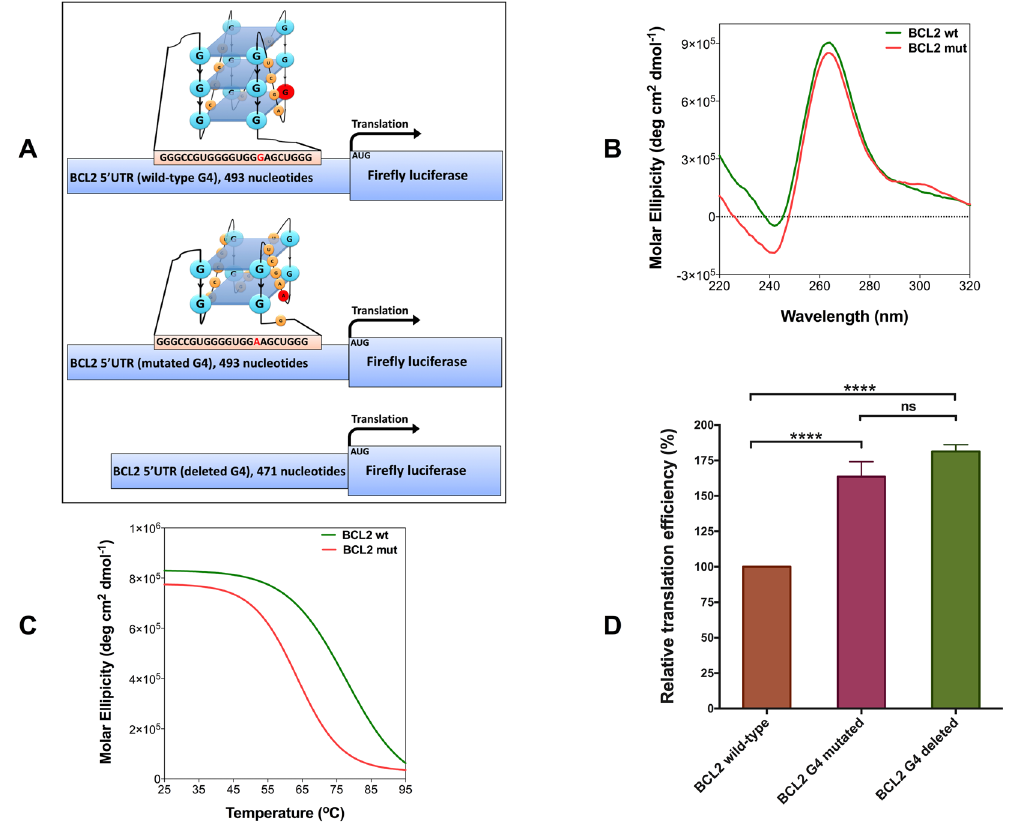
Figure 3. A point mutation in the 5 ′ UTR of BCL2 destabilises the RNA G4 and affects its regulatory function. ( A ) Schematic representation of three different mRNAs of firefly luciferase reporter constructs. Wild-type construct contains full-length 5 ′ UTR of BCL2 . In the G4-mutated construct, one of the guanines is replaced by adenine. To make the G4-deleted construct, 22 nucleotides that form the G4 were deleted. Schematic drawing of wild-type and mutated G4s are proposed based on RNAfold and QGRS-mapper predictions and in vitro results. ( B ) CD spectra of BCL2 wild-type and mutated RNA G4 oligos in KCl. ( C ) CD melting curves of BCL2 wild-type and mutated RNA G4 oligos at 260 nm. ( D ) Relative in vitro translation efficiency of the wild-type, G4-mutated and G4-deleted constructs as judged by measuring firefly luciferase enzymatic activity. Data were analysed using one-way-ANOVA (n ≥ 3, error bars represent the SEM, asterisks ( * ) indicate significance calculated by the Tukey multiple comparisons test, ns indicates non-significant).